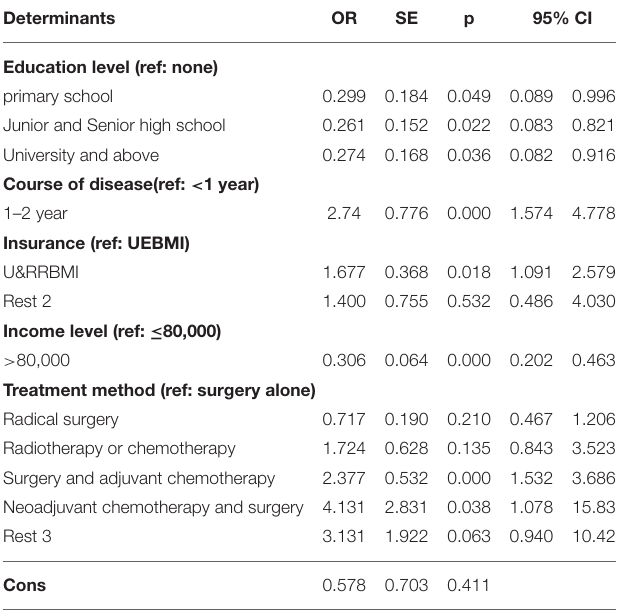
TABLE 3 | Multivariate logistic regression model of determinants of